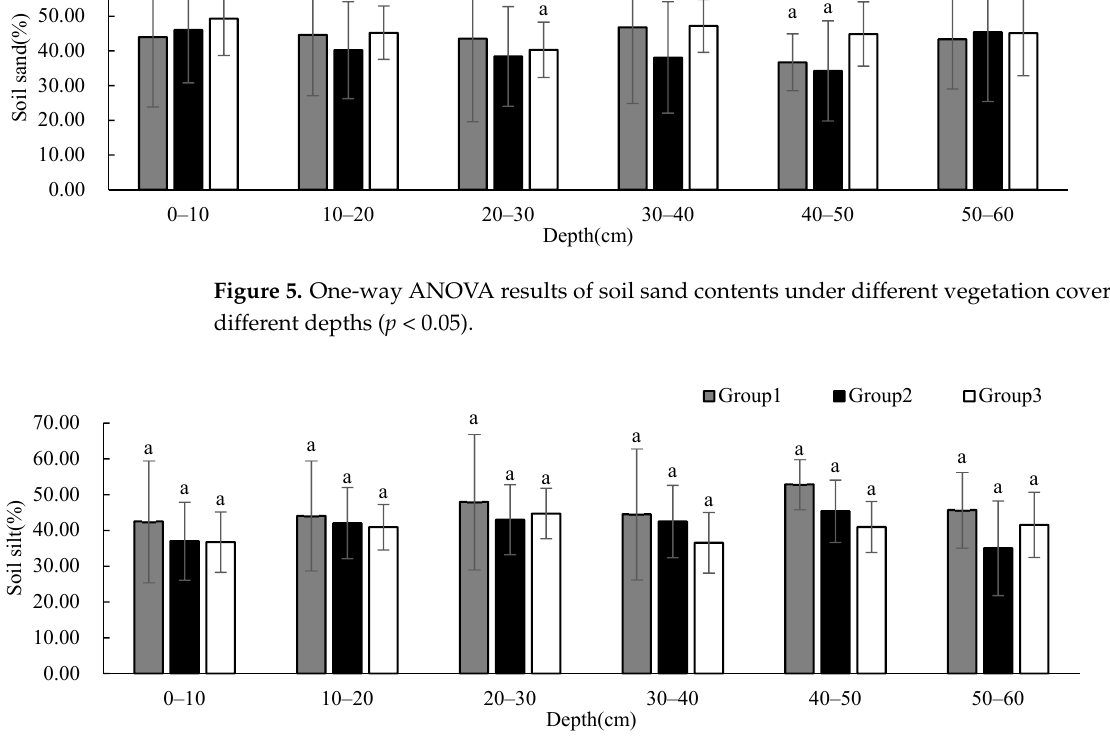
Figure 6. One-way ANOVA results of soil silt contents under different vegetation cover types at different depths ( p < 0.05).